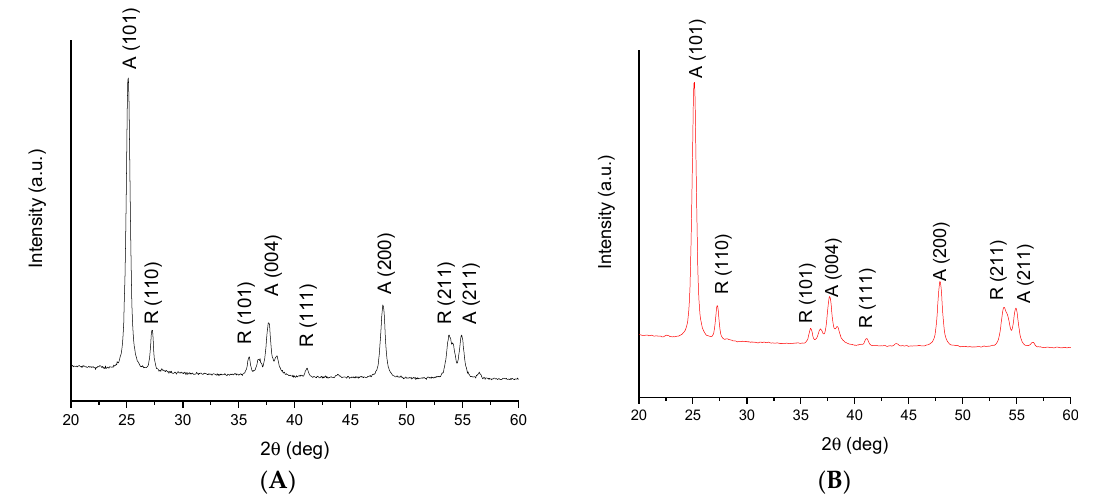
Figure 3. XRD pattern of the commercial Aeroxide P-25 photo-catalyst: ( A ) fresh catalyst; ( B ) after 5 catalytic cycles, each of 5 h.